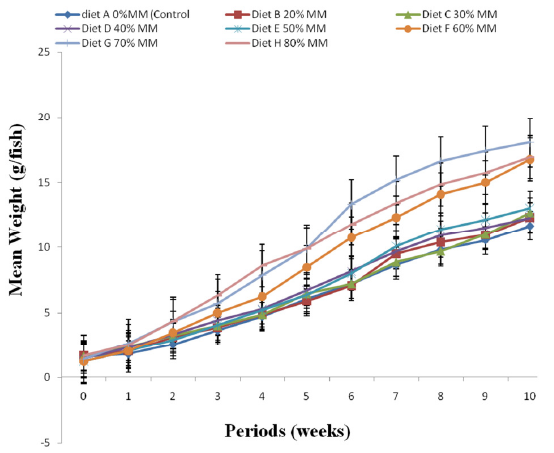
Fig. 6. Weekly weight changes of Clarias gariepinus fingerlings fed the various experimental diets